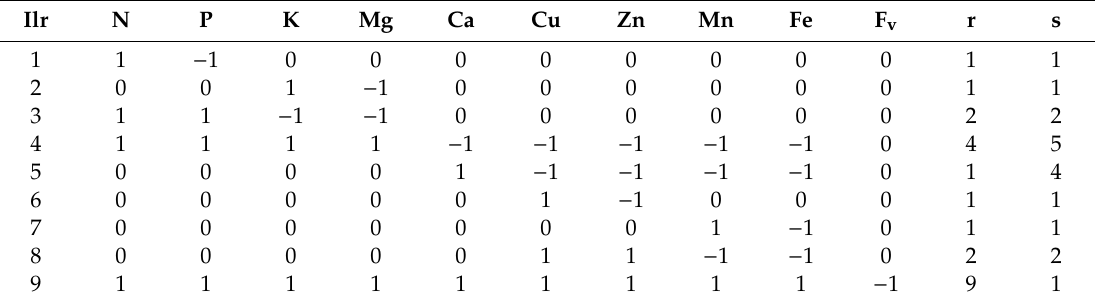
Table 1. Sequential binary partition of components of the dry tissue